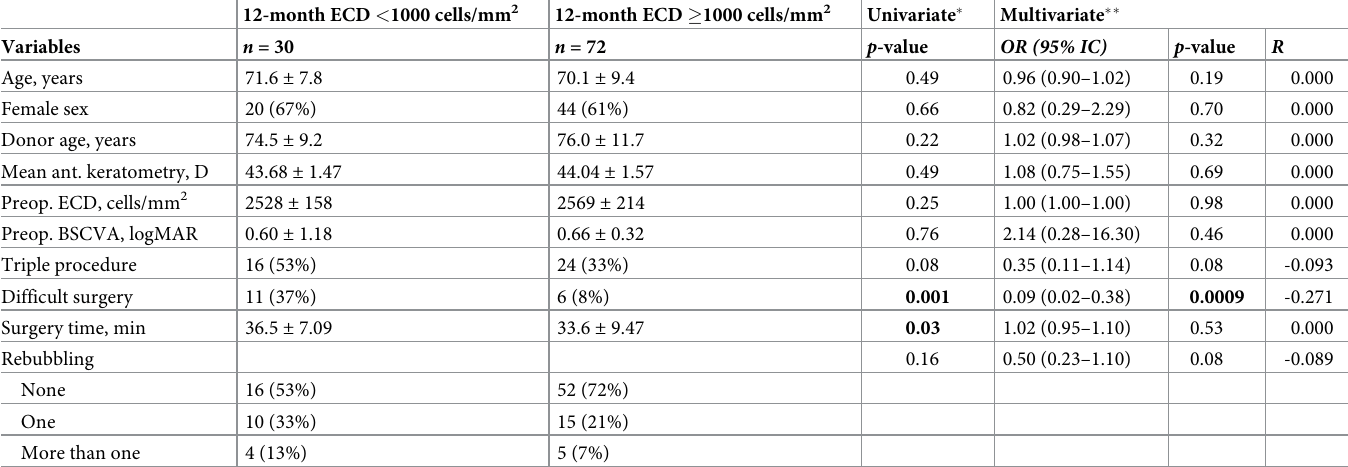
Table 5. Comparison of patients with 12-month ECD < 1000 and � 1000 Cells/mm 2 in terms of preoperative and perioperative